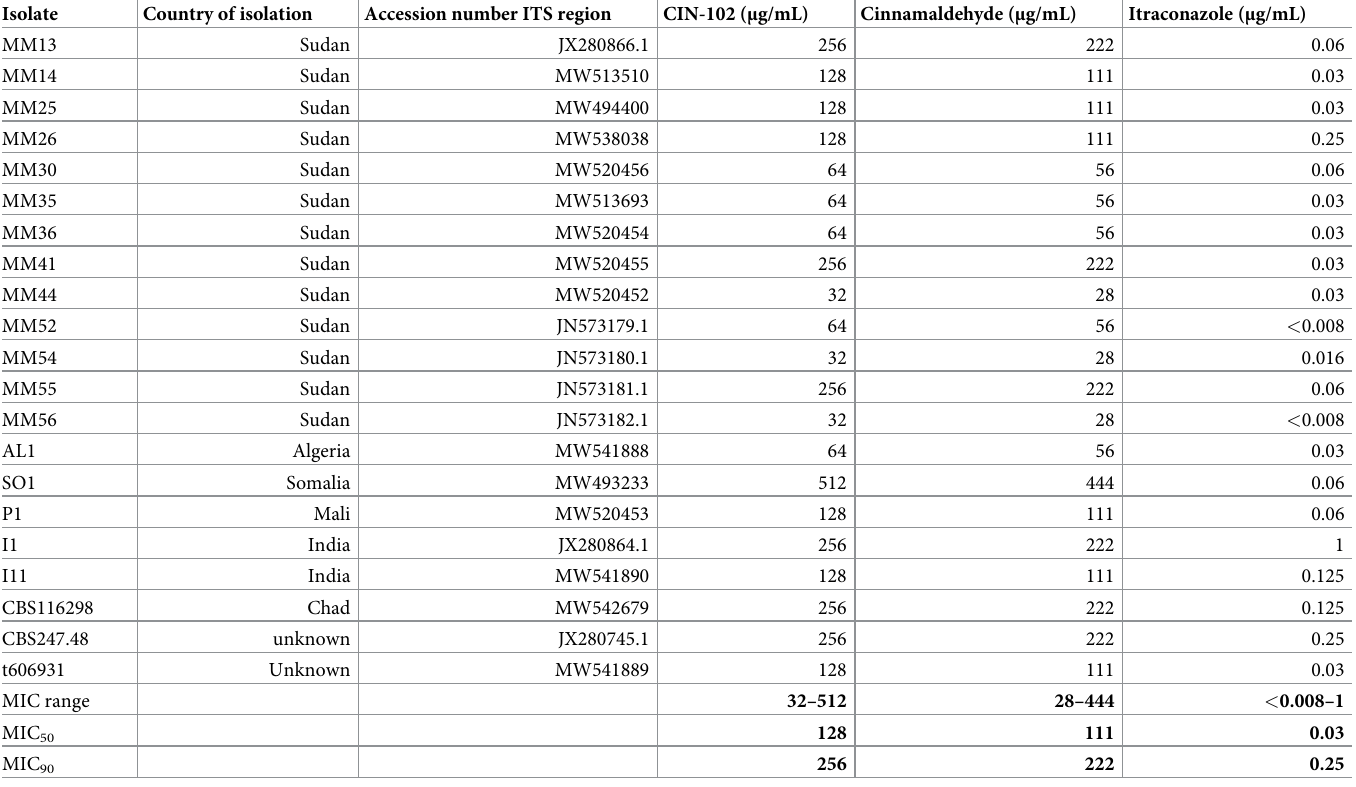
Fig 1. Antifungal susceptibility of 21 M . mycetomatis isolates to CIN-102 and itraconazole expressed as MICs, determined by the XTT assay. https://doi.org/10.1371/journal.pntd.0009488.g001 Table 2. In vitro susceptibility of all included M . mycetomatis isolates to CIN-102 and itraconazole expressed in μ g/mL. The country of isolation and accession num- ber for each isolate is s The corresponding concentrations of cinnamaldehyde have been calculated and shown in μ g/mL. The MIC ranges, MIC50 and MIC90 to M . mycetomatis are shown in μ